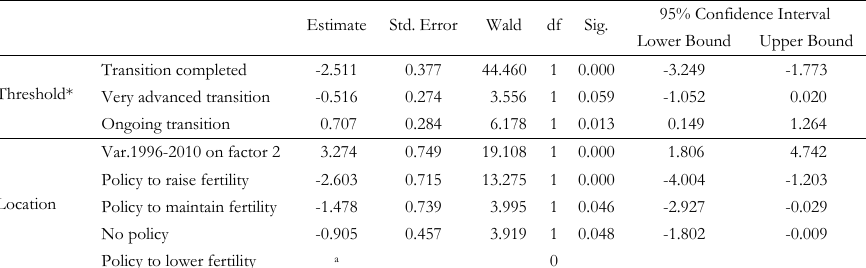
95% Confidence Interval